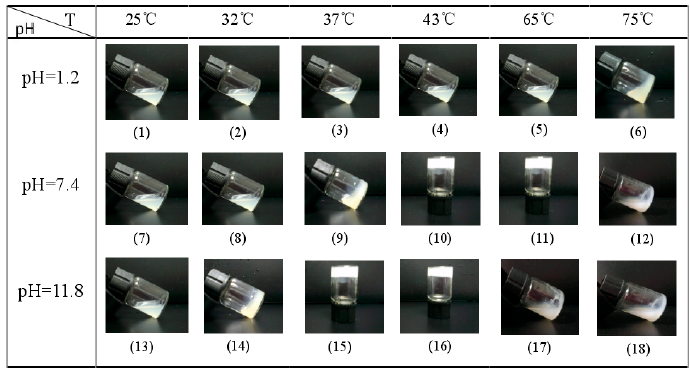
Figure 9. Photo of P2 aqueous solution at 25, 32, 37, 43, 65, and 75 °C (30 mg·mL − 1 , at pH 1.2, 7.4, and 11.8).